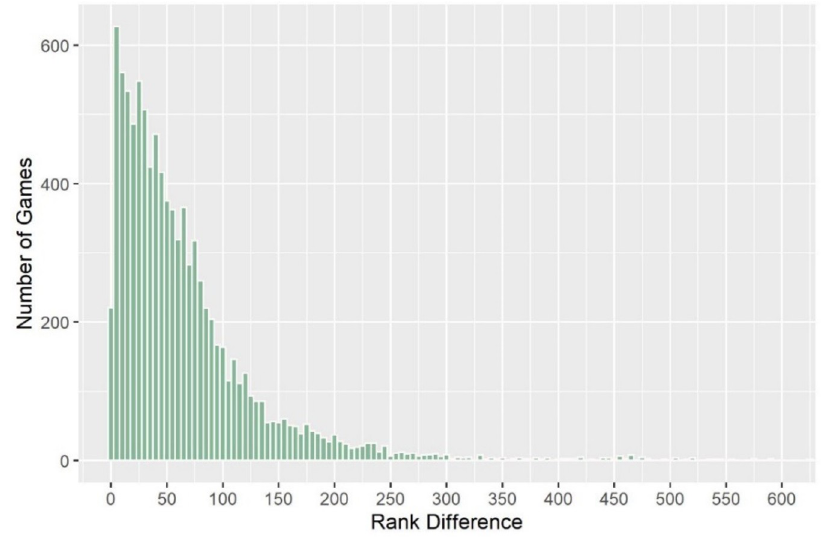
Fig 3. Histogram of ranking differences (ATP